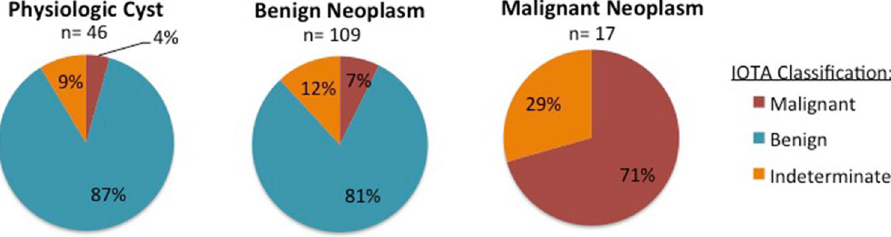
Figure 1. Final pathology correlates with IOTA classification: 172 adnexal masses underwent surgical removal the final pathology of which was categorized as physiologic, benign or malignant with each category represented by a chart above. 46 (27%) were physiologic cysts, 109 (63%) were benign neoplasms and 17 (10%) were malignant neoplasms. Prior to the decision to go to the OR, each of these masses was categorized by the IOTA classification system as malignant, benign or indeterminate, delineated by different colors in the charts